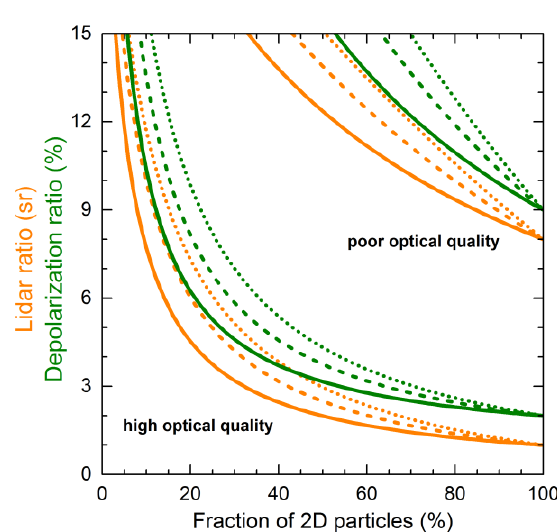
Figure 4. Cirrus lidar ratio and depolarization ratio as functions of the fraction of horizontally aligned ice particles. For the calculations, common 3D values of 25 sr and 40%, respectively, are selected. Assumed 2D values fall in the ranges of the lowest 2D lidar and depolarization ratios ever measured with RAMSES (high optical quality, 1 – 2 sr, 1% – 2%) or are chosen to illustrate the effect of poor particle optical quality (8 sr, 9%). Results are presented for aspect ratios of 0.5 (solid curves), 1.0 (dashed curves), and 1.5 (dotted